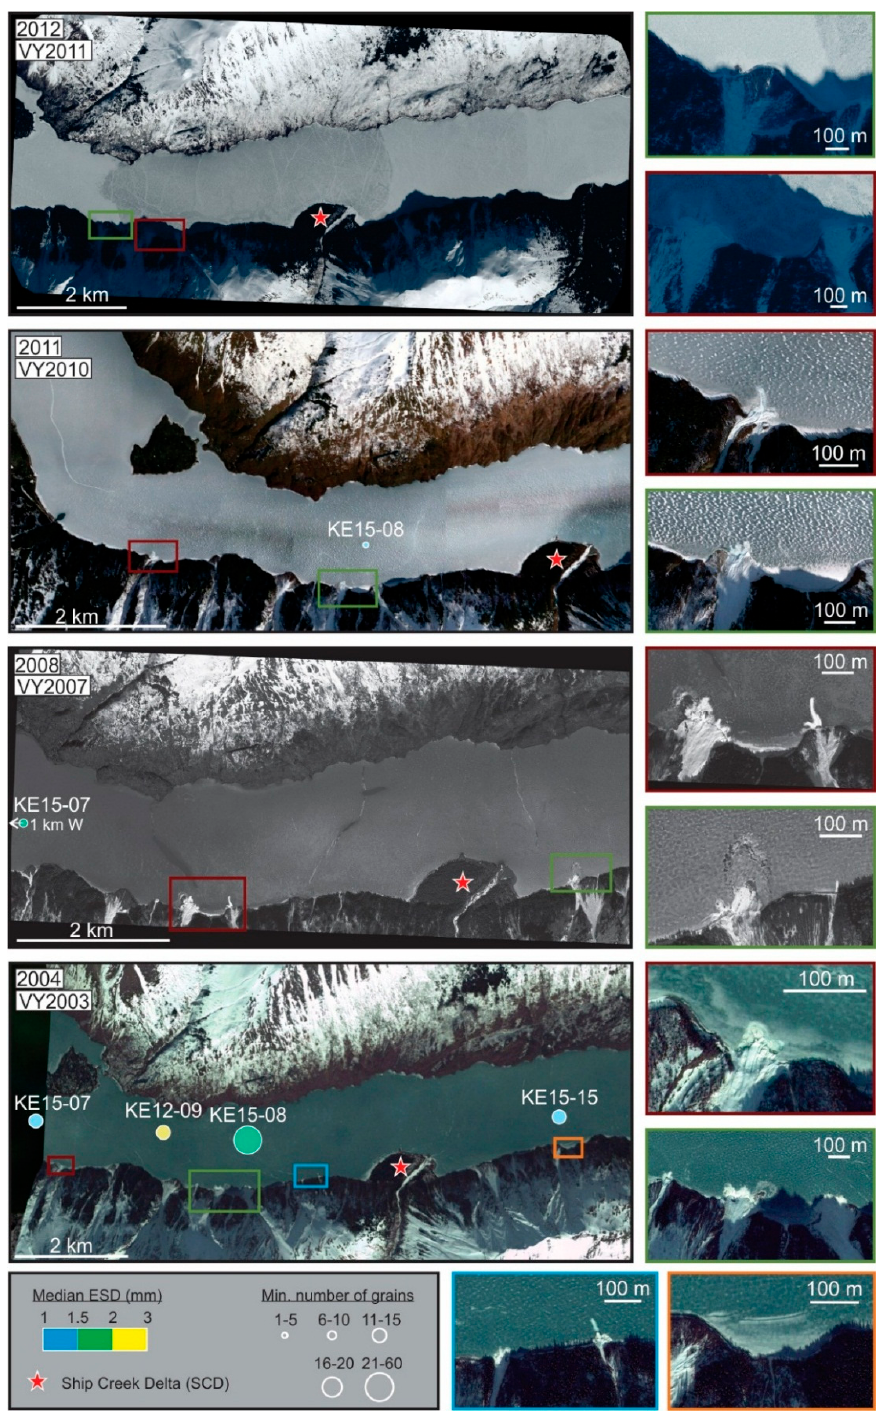
Figure 4. Left: Satellite images of the central basin of Kenai Lake, from April 14, 2004, April 28, 2008, April 17, 2011, and April 2, 2012. Plotted on the satellite images are the locations of cores, in which debris was found at the top of the varve of the previous varve year. In addition, the median grain size and the number of grains found in that varve of each core are plotted. The Ship Creek Delta (SCD) is indicated with a red star as a reference point. Most of the avalanches (six in 2004, two in 2008, two in 2011, and four in 2012) occurred around the western part of the central basin and two (2004 and 2008) are observed in the eastern part. Avalanches in 2004 and 2008 consist of snow and debris, while those in 2011 and 2012 only show snow. Right: Magnified images of avalanches.